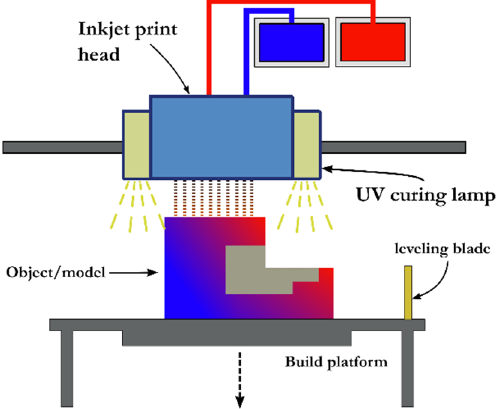
Figure 6. Process description of MJ.